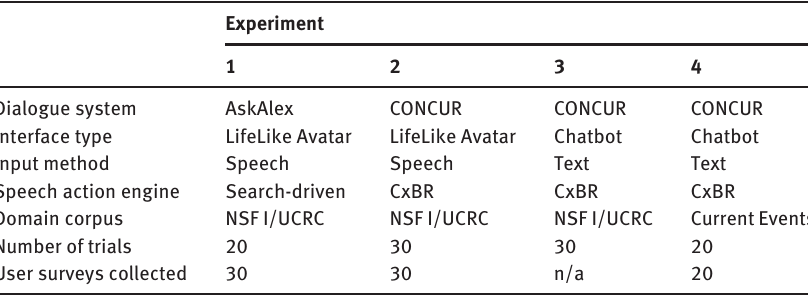
Table 4. Dialogue System Data Set Collection